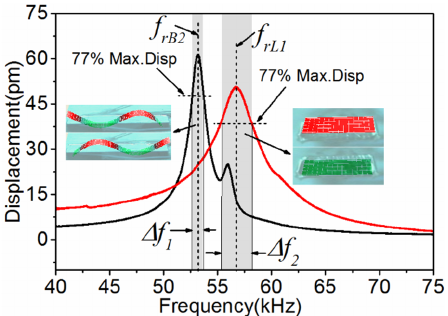
Figure 7. Vibration scan results of the stator using Doppler vibrometer.